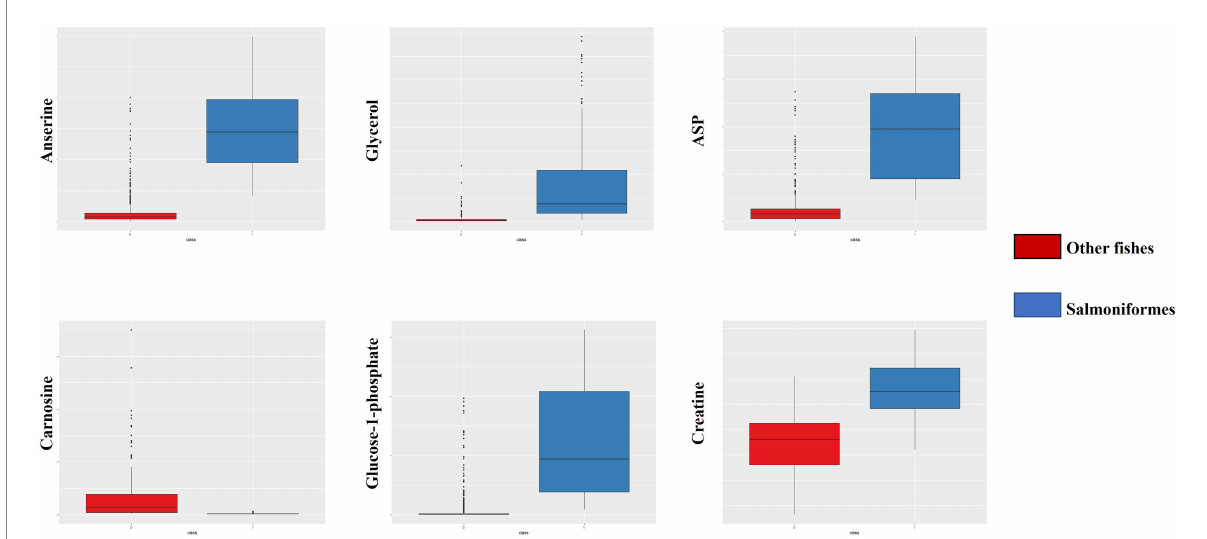
FIGURE 2 Box plot of important factors of NMR data. From the upper left, the panel indicates anserine, glycerol, and aspartic acid. From the lower left, the panel indicates carnosine, glucose-1-phosphate, and creatine. The red box indicates other fish data, and the blue box indicates salmoniformes. It can be seen that salmoniformes had higher scores, except for carnosine. The vertical axis indicates the composition ratio to the total amount of intensity. In the NMR panels, the number of other fishes is 1858 and the number of salmoniformes is